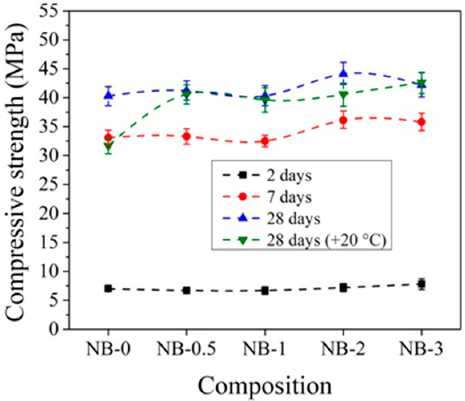
Figure 12. Compressive strength of concrete with CEM IIN samples at +5 °C initial curing (28 days (+20 °C)—reference samples prepared and cured at +20